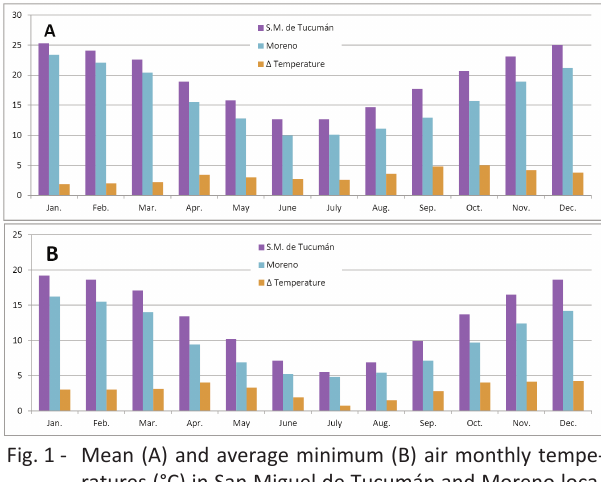
Fig. 1 - Mean (A) and average minimum (B) air monthly tempe- ratures (°C) in San Miguel de Tucumán and Moreno loca-